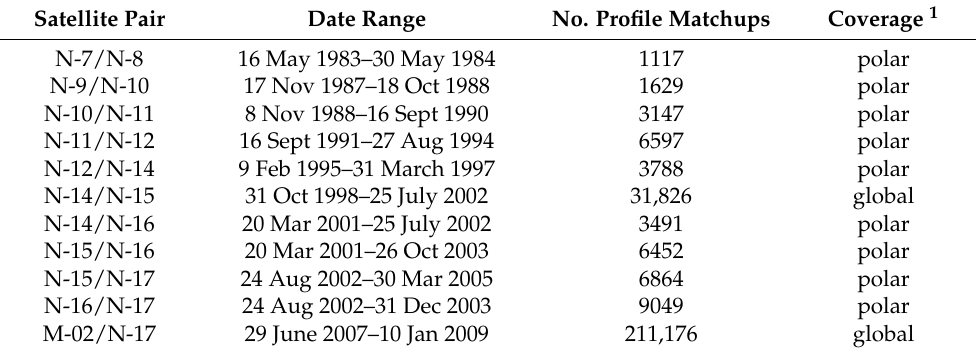
Table 1. Eleven satellite pairs with temporal overlap. Satellite pairs, date range of overlap, number of profile matchups, and coverage characteristics are described. Data were considered a match if within 0.02 ◦ latitude and longitude and one hour of measurement. Satellite Pair Date